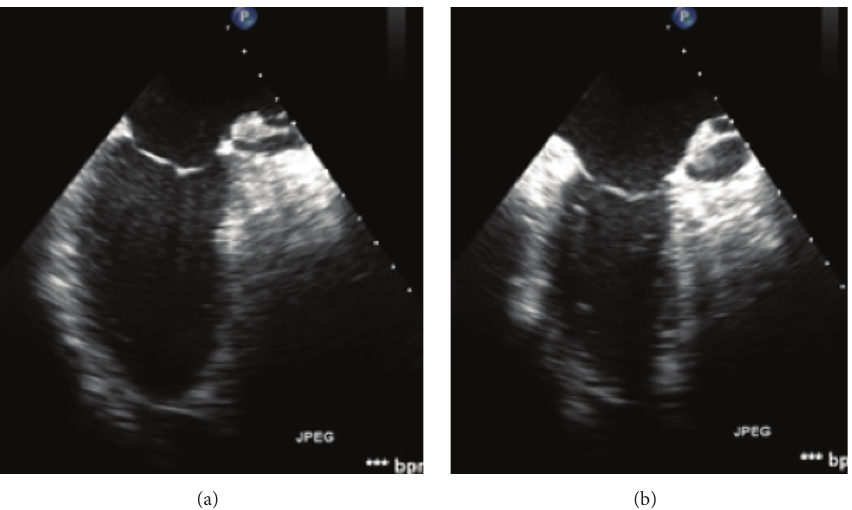
Figure 1: Transesophageal echocardiogram while on pentobarbital infusion, left ventricle ejection fraction of 20%: (a) end diastole; (b) end systole.